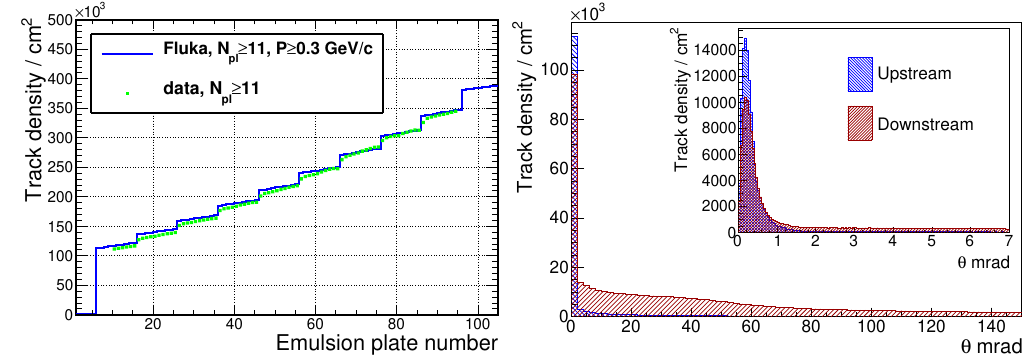
Figure 16 . Left: the evolution of track density as a function of depth in a module, compared with the FLUKA simulation (without reconstruction, however with momentum threshold of 0.3 GeV). Right: comparison of track angular density (tracks/cm 2 /bin) between an upstream unit and down- stream. They correspond to plate number 6 and 86 in the left